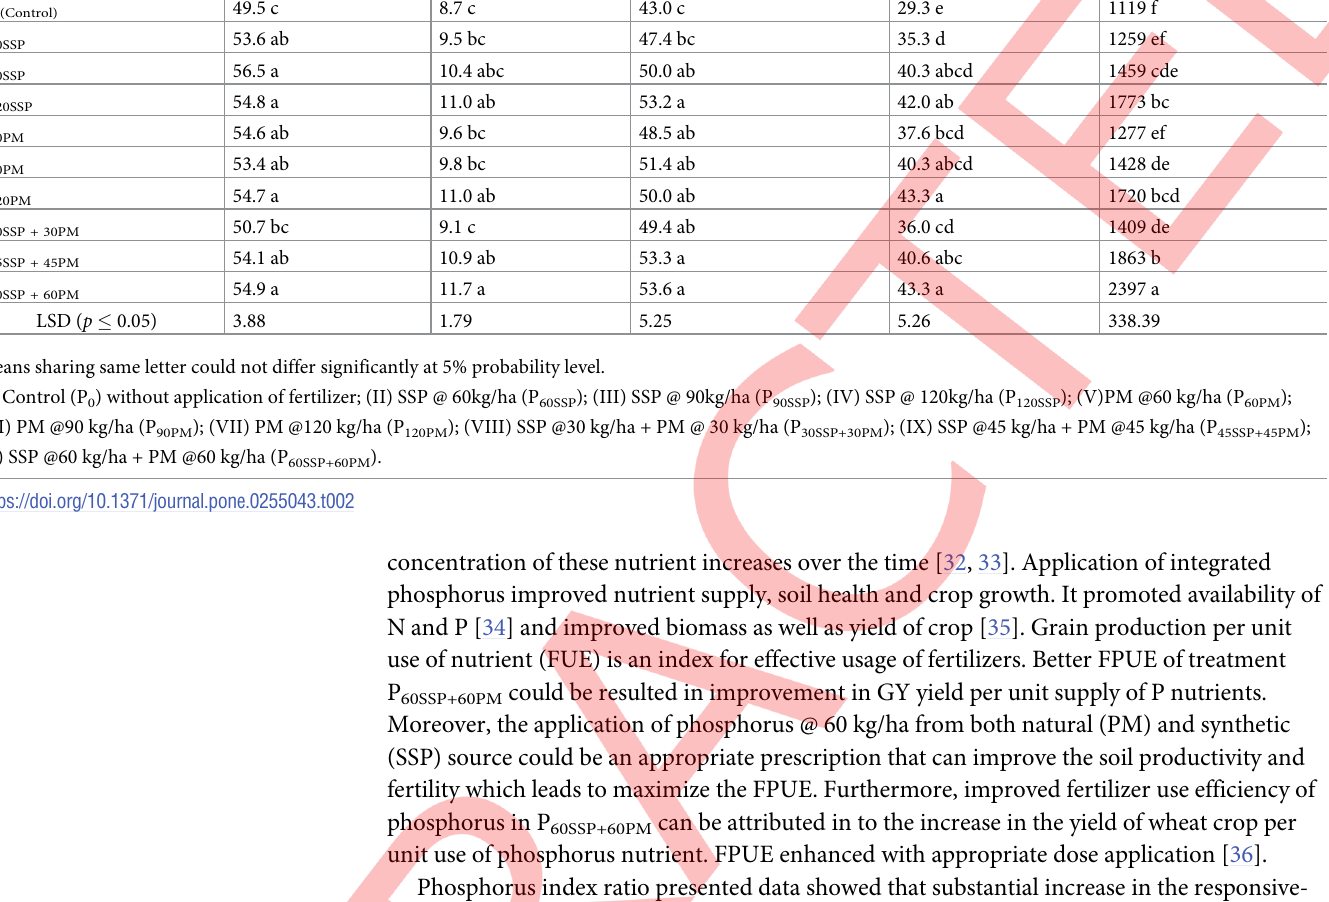
Table 2. Effect of various organic and inorganic P nutrient sources on yield and yield components of wheat. Treatments